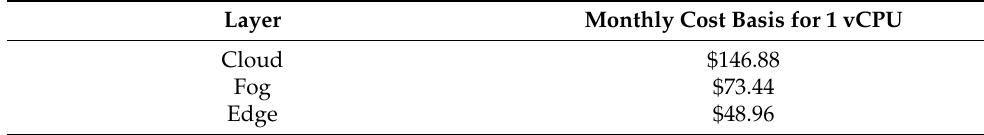
Table 5. Cost basis of VM instances in edge, fog, and cloud computing